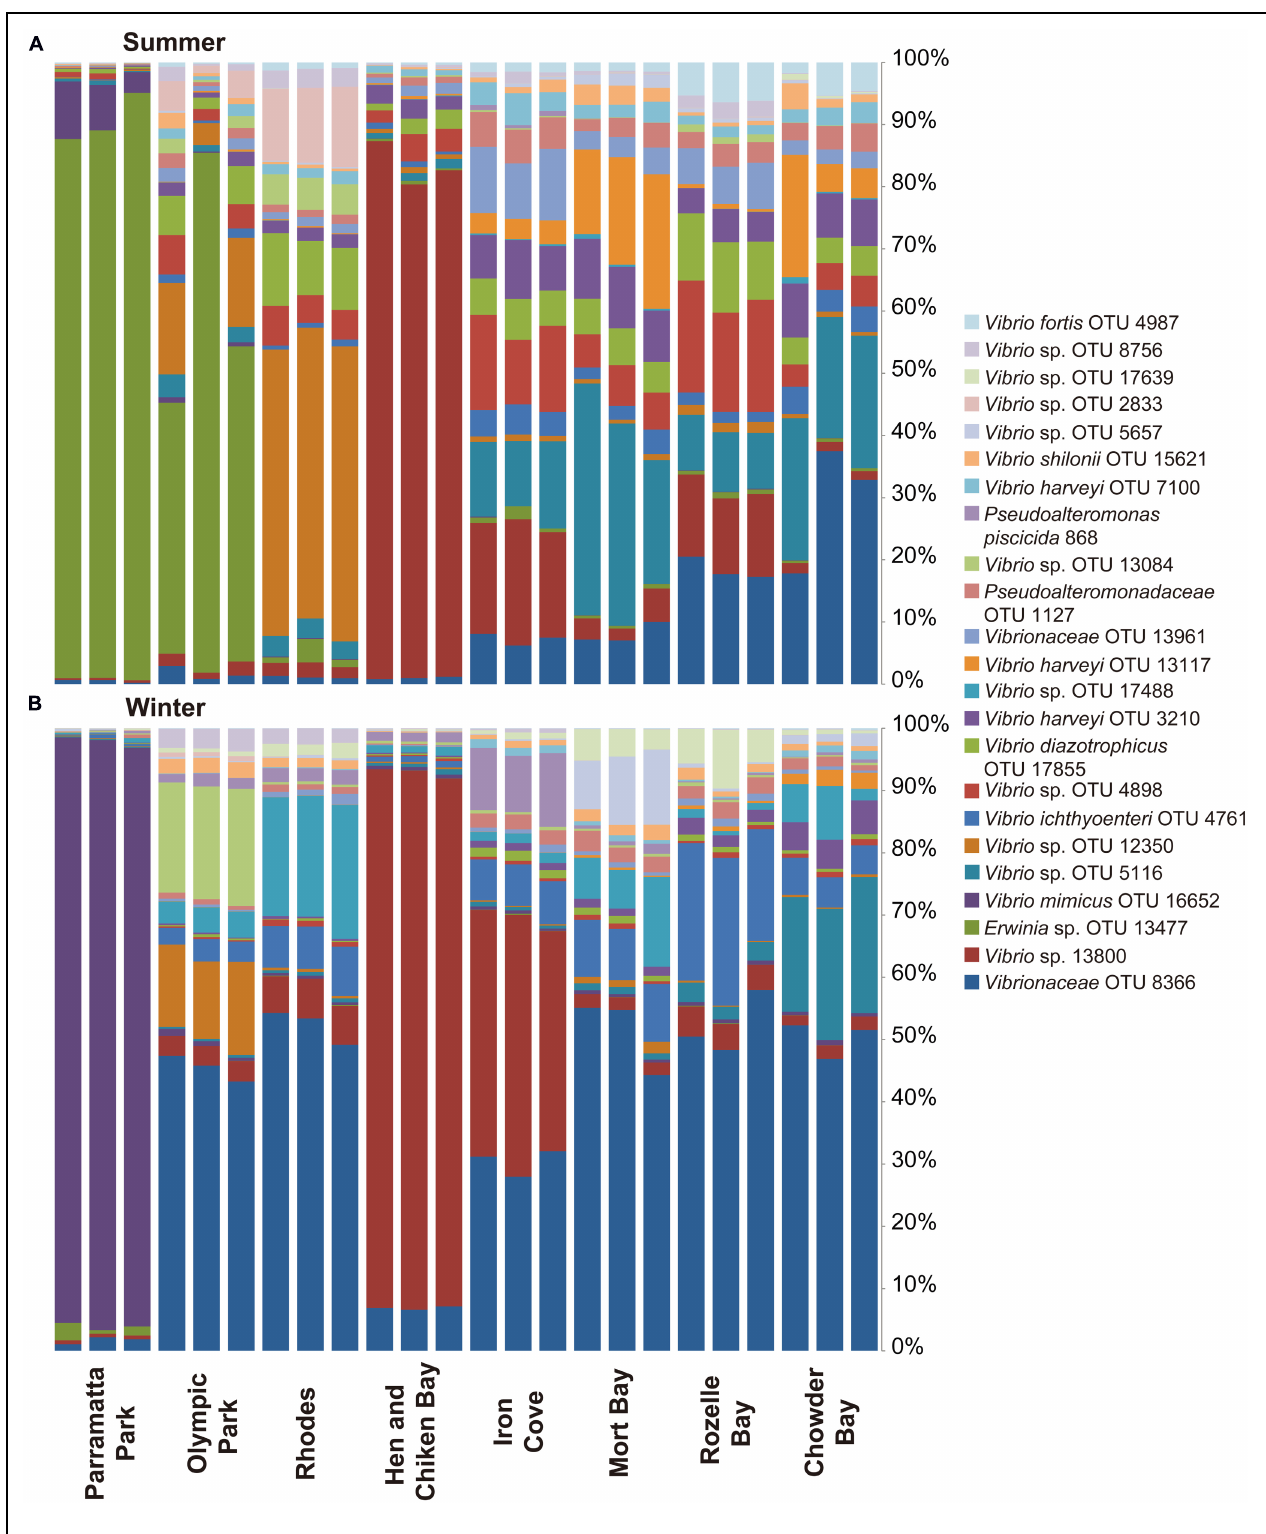
FIGURE 5 | Most abundant Vibrio OTUs (representing 67.5% of the total normalized sequences during winter and summer. The figure displays the distribution of OTUs (for graphical reasons only OTUs that represent > 0.5% of the total sequences were included) at the different sites, ranging from Parramatta Park in the west to Chowder Bay in the east: (A) summer sampling time (March), (B) winter (June).